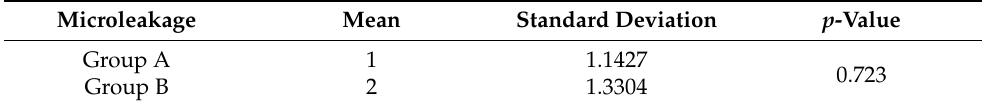
Table 1. Microleakage in the oblique (Group A) and horizontal (Group B) layering technique.